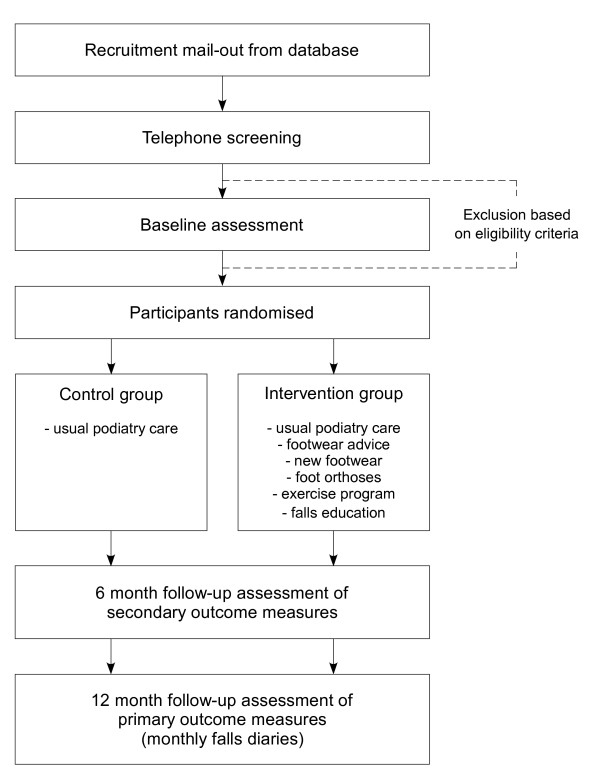
Design of study.